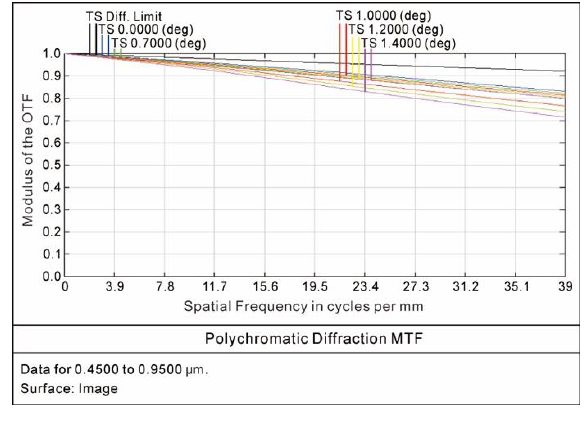
Figure 7. MTF curves.